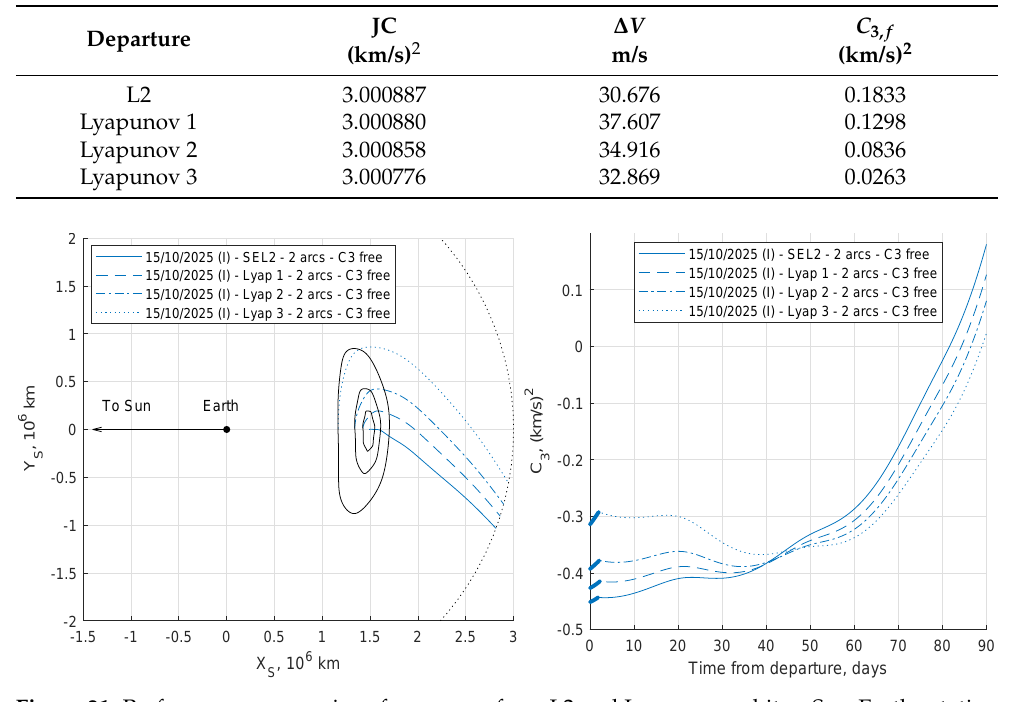
Figure 21. Performance comparison for escapes from L2 and Lyapunov orbits—Sun-Earth rotating RF ( left ), energy over time ( right )—free C 3 , fixed t f 90